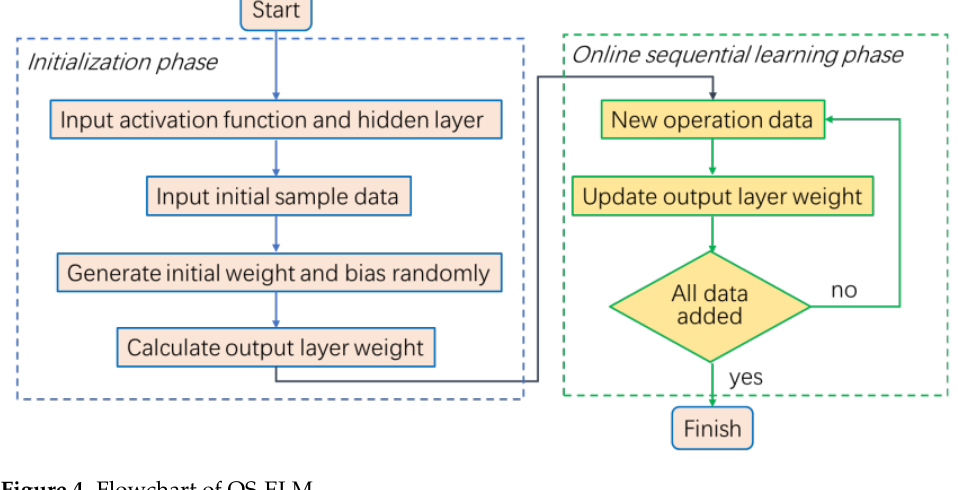
Figure 4. Flowchart of OS-ELM.